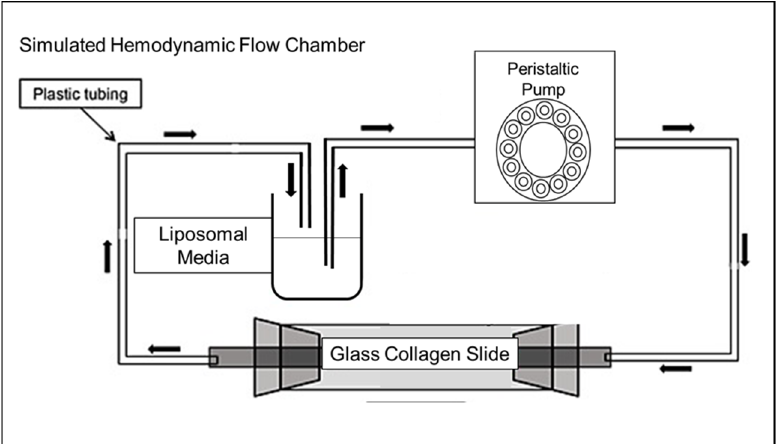
Figure 3. Schematic representation of the FCS3 parallel-plate flow chamber setup used for the simulated hemodynamic flow.